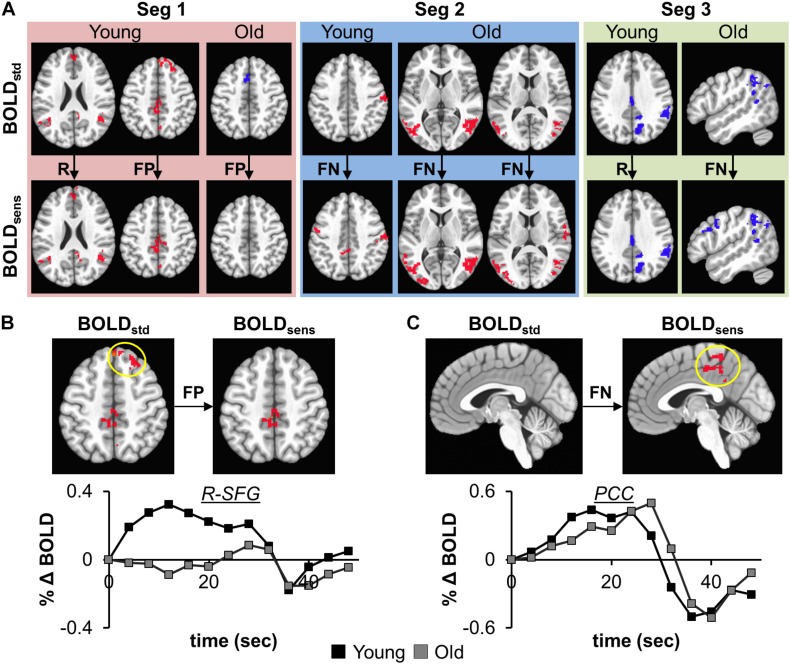
(A) depicts the effectiveness of task-BOLD sensitization using age-retained CBF for each segment (Seg 1–3). The effectiveness of sensitization is characterized based on removal of false positives (FP), identification of false negatives (FN), and retaining (R) expected activity. Red depicts increased BOLD activity while the blue depicts decreased BOLD with respect to the baseline BOLD activity. The bottom panels show the cluster-averaged hemodynamic response function quantified from standard BOLD activity in right superior frontal gyrus (B, FP) and posterior cingulate (C, FN) in young participants (p < 0.01, FWE corrected). Yellow circle denotes the brain area. The axial images are in neurological convention. BOLDstd refers to Z(AUC)standard and BOLDsens refers to Z(AUC)residual in the methods section.